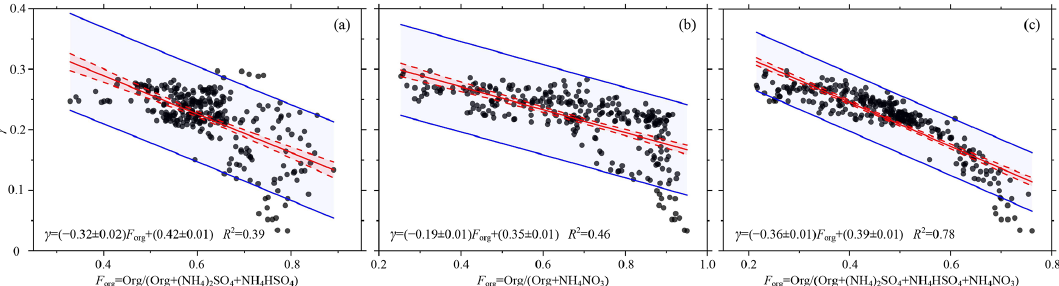
Figure 5. Scatter plots of γ as a function of the relative amounts of organic and inorganic matter ( F org ): (a) F org = Org /( Org + ( NH 4 ) 2 SO 4 + linear fits, dotted red lines represent the 95% confidence levels, and solid blue lines represent the 95% prediction bands for the fit. The linear regression function and the squared Pearson’s correlation coefficient ( R 2 ) are given in each